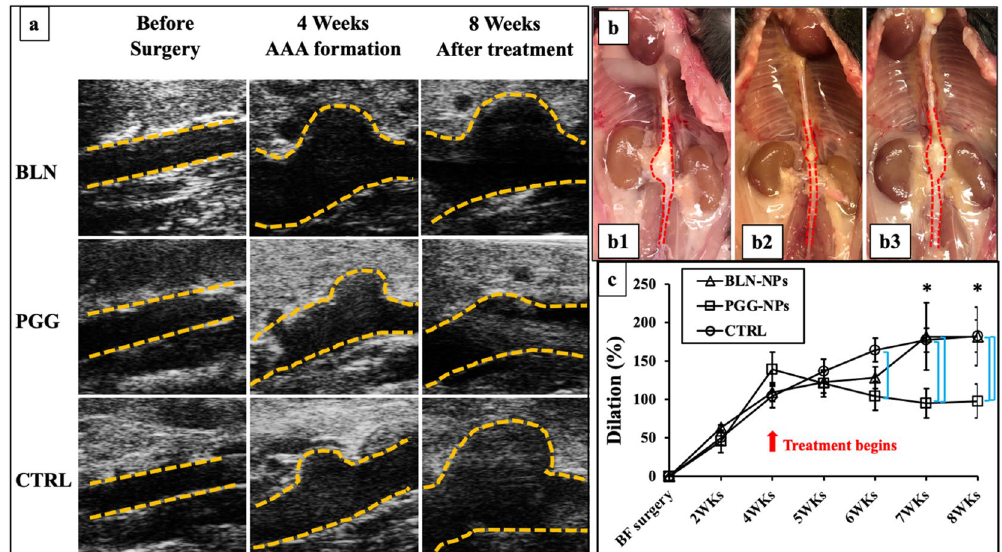
Figure 3. In vivo ultrasound and dilation change. ( a ) Representative B-mode in vivo ultrasound images of abdominal aortas before pump implantation, at 4 weeks when the infusion of Ang II was finished and treatment started, and 8 weeks when the animals were euthanized; ( b ) Gross view of representative aortas from BLN-NPs (b1), PGG-NPs (b2) and control groups (b3) at 8 week; ( c ) Dilation percentage of BLN-NPs group, PGG-NPs group and control group. After therapy PGG-NPs group showed progressive reversal of aneurysmal dilation while control and BLN-NPs groups showed continuous increase in aneurysms. *Indicate timepoint that have dilation percentage significantly different from week 4 (p < 0.1); bars indicate significant difference between groups (p <